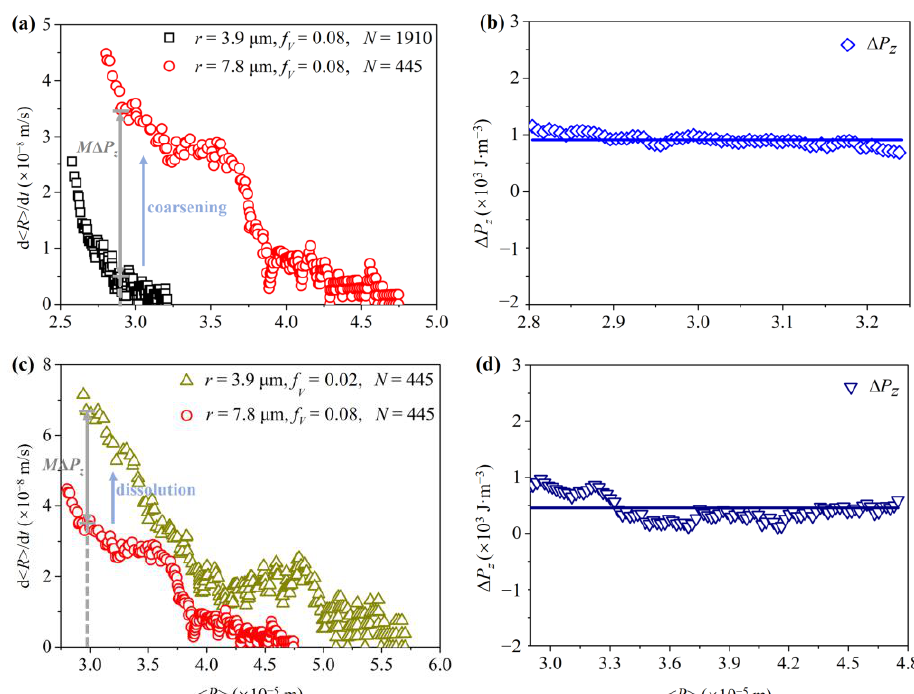
Figure 3. Calculation results for the grain boundary moving velocities and pinning force differences of the particles. Differences of grain boundary moving velocity between ( a ) simulation conditions A and C and ( c ) simulation conditions B and C. Differences of the pinning force between ( b ) simulation conditions A and C and ( d ) simulation conditions B and C.